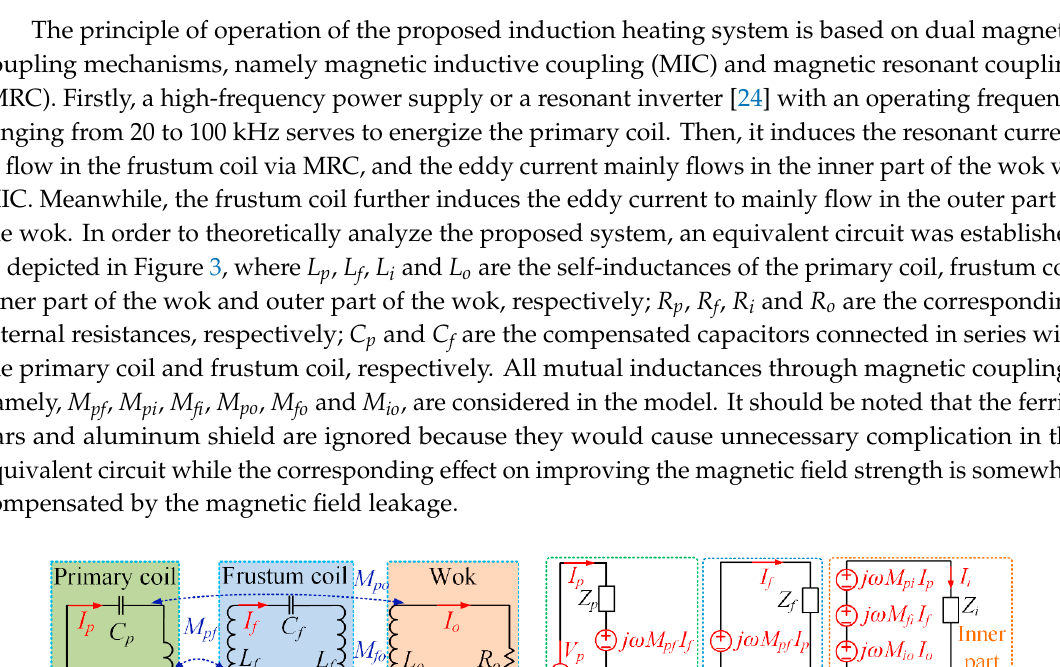
Figure 2. Proposed induction heating system.